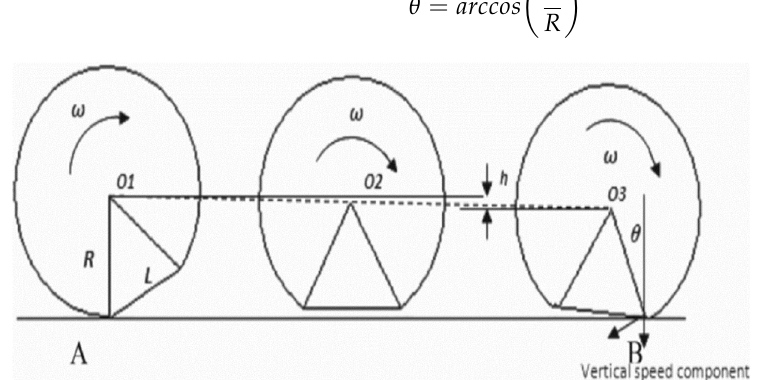
Figure 9. Principle of wheel and rail collision by wheel flat [19].